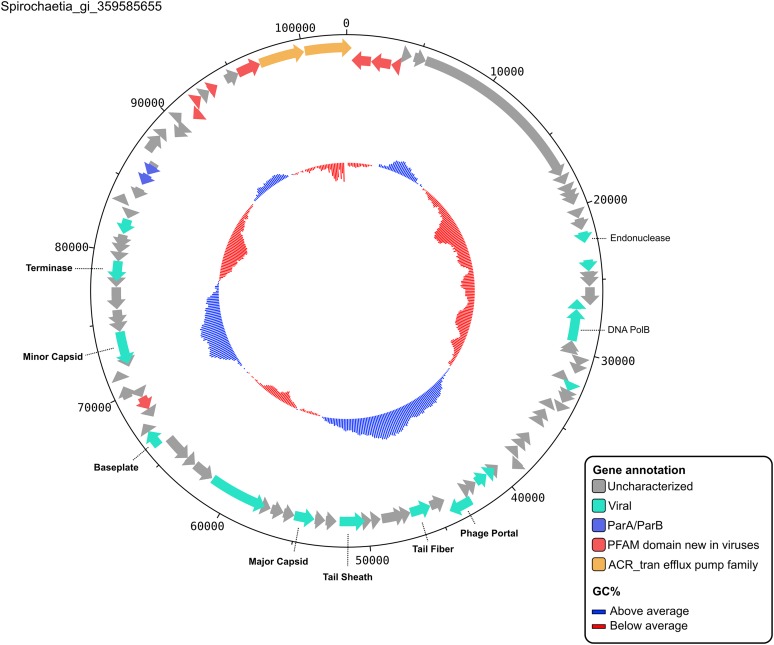
Contig map of a putative new extrachromosomal prophage.Contig Spirochaetia_gi_359585655 represent a complete genome (the contig was detected as circular) from a new genus (affiliated to a VC with no RefSeqABVir sequence). Functional affiliation of predicted genes is indicated on the map, with notably two genes (ParA/ParB) indicative of extrachromosomal prophages, as well as two genes (in orange) affiliated to the ACR_tran efflux pump family, of which some members are involved in antiobiotic resistance phenotypes. This contig belongs to the virus cluster VC_61, composed of 35 new putative extrachromosomal prophages from different Spirochetes genomes.